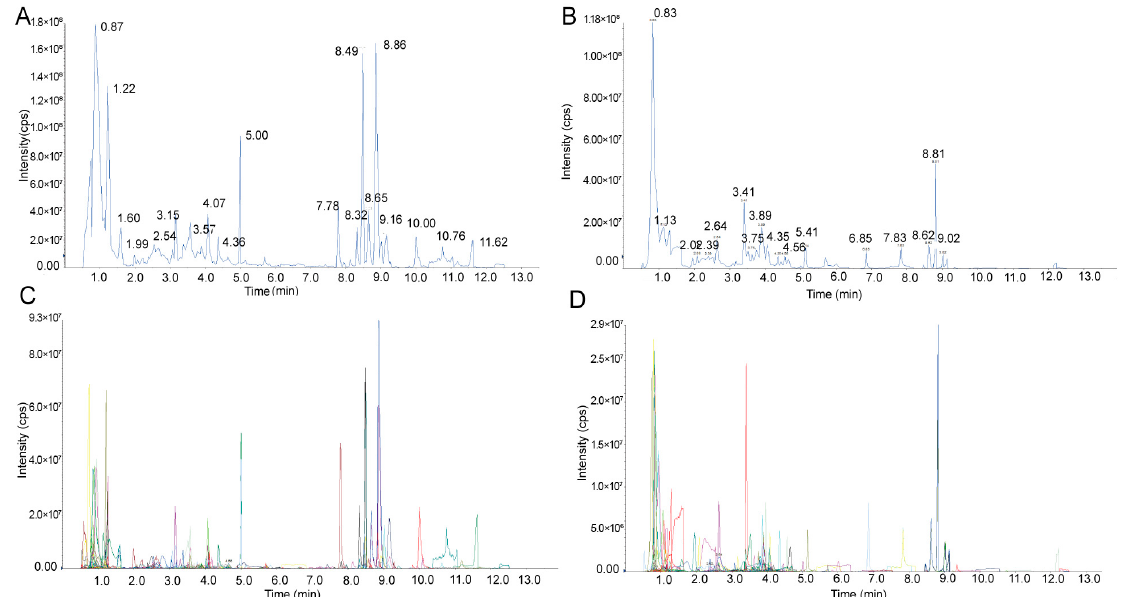
Figure 2. Total ion current of one quality control sample by mass spectrometry detection in ( A ) positive mode and ( B ) negative mode. Multi-peak detection plot of metabolites from multiple reaction monitoring in ( C ) positive mode and ( D ) negative mode.